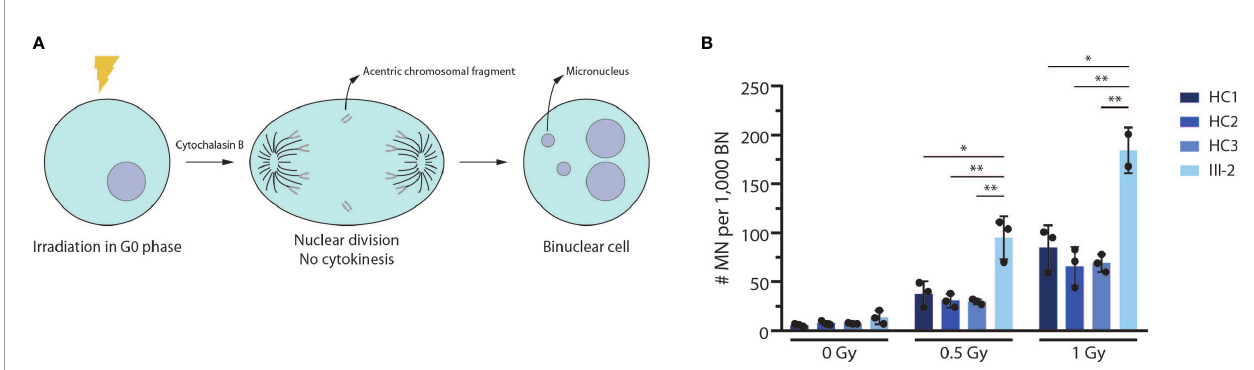
FIGURE 5 | Truncated patient-derived ARTEMIS protein is unable to contribute to DNA repair in a G0 micronucleus assay. (A) Schematic representation of the G0 micronucleus assay. Fibroblasts are irradiated at the G0 phase of the cell cycle before addition of cytochalasin B to block cytokinesis. Upon nuclear division, the micronuclei (MN) resulting from acentric chromosomal fragments can be counted relative to the amount of binucleate cells (BN). (B) Graph showing the relative abundance of micronuclei compared to binuclei in 3 independent healthy control and patient fi broblast lines. Cells are irradiated with increasing intensities of Gray (Gy). Bars indicate the mean of the 3 independent experiments that are shown by the individual data points and error bars indicating the standard deviation (n=3). **indicates p < 0.01 and * indicates p < 0.05 resulting from a two-tailed paired t-test. HC, Healthy